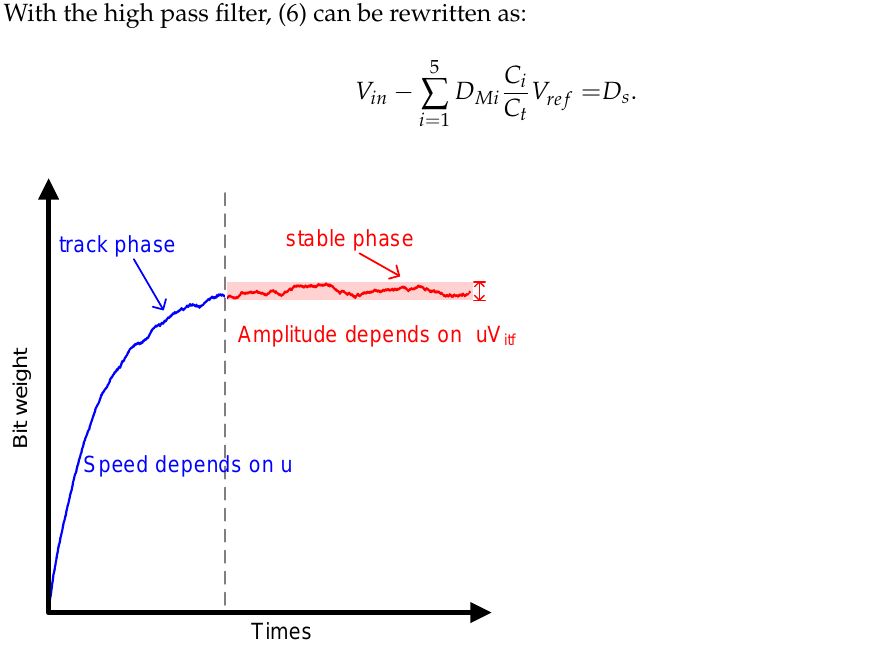
Figure 3. Bit-weight learning curve.